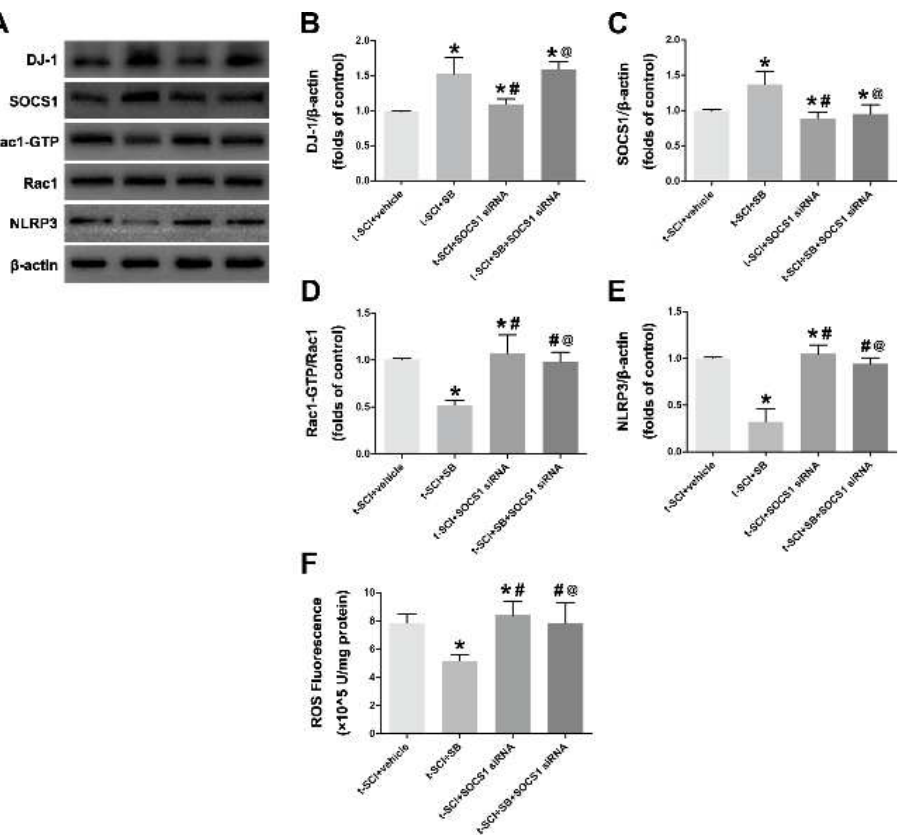
Figure 6. DJ-1 mediated NLRP3-related neuroinflammation through SOCS1. ( A – E ): Representative Western blotting images of DJ-1, SOCS1, Rac-GTP and NLRP3. ( F ). Quantification of ROS. * p < 0.05 vs. t-SCI + vehicle; # p < 0.05 vs. t-SCI + SB; @ p < 0.05 vs. t-SCI + SOCS1 siRNA.